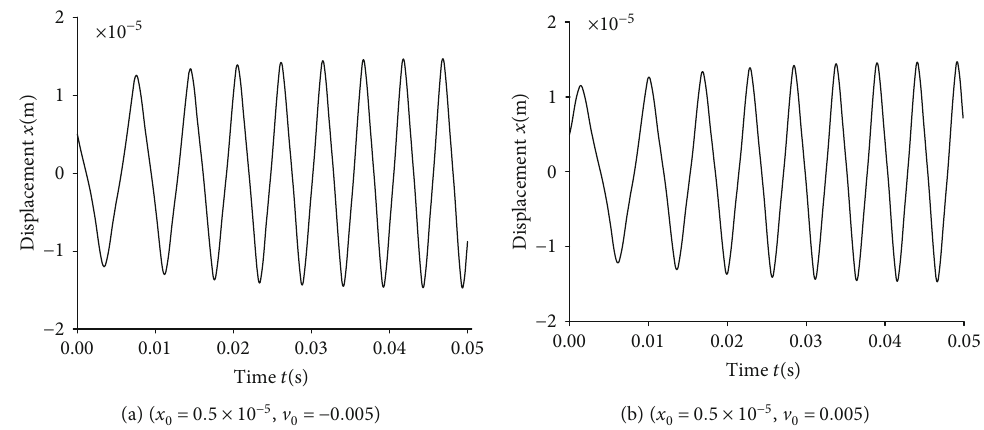
= 1 : 6A , q = 1 : 0 × 10 − 4 m 3 /s . 0 0